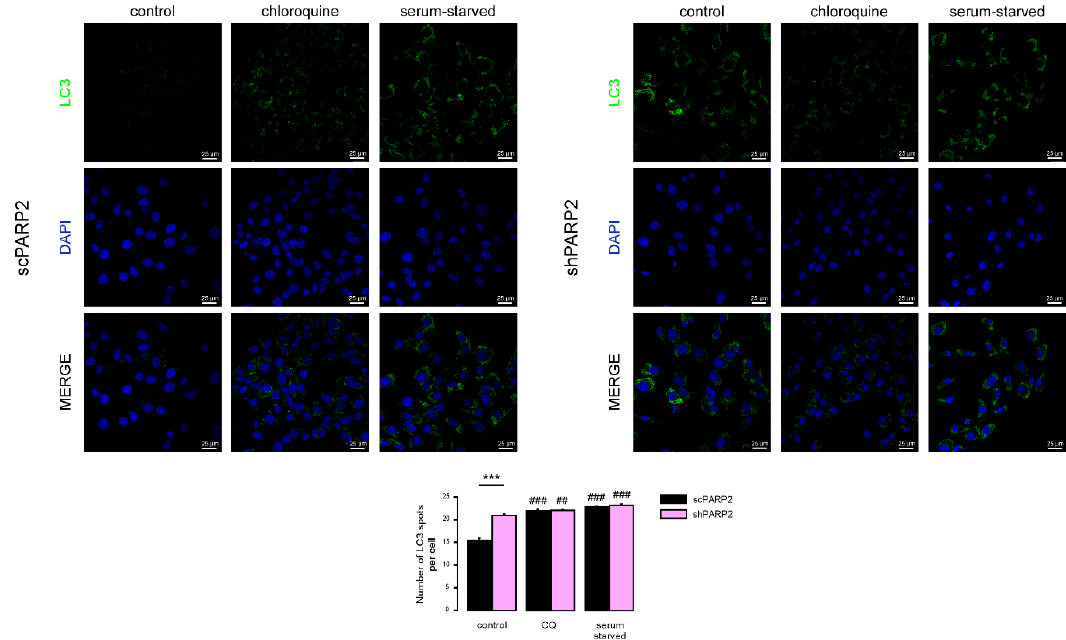
Figure 5. Chloroquine and serum starvation induce LC3 expression in scPARP2 and shPARP2 cells to the same extent. scPARP2 and shPARP2 C2C12 cells were treated with 25 µM chloroquine for 2 h or serum-starved for 12 h. LC3 expression was assessed in confocal microscopy experiments. Alexa Fluor 488-linked LC3 specific antibody was used and the nuclei were visualized using DAPI, vesicles were counted. Representative images are presented on the figure. ## and ### represent statistically significant differences between the control and chloroquine-treated or control and serum-starved cells at p < 0.01 or p < 0.001, respectively. *** represent statistically significant differences between the scPARP2 and shPARP2 cells at p < 0.001. For the determination of statistical significance ANOVA test was used followed by Tukey’s post hoc test.